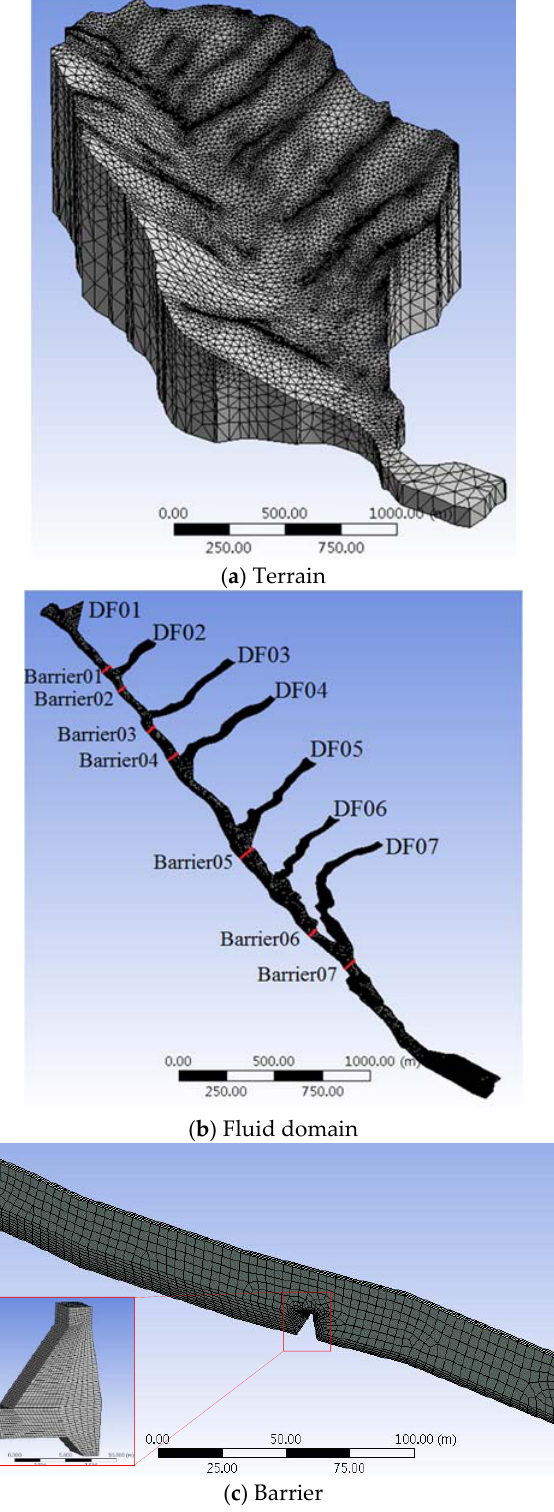
Figure 5. Mesh example with tetrahedron elements.